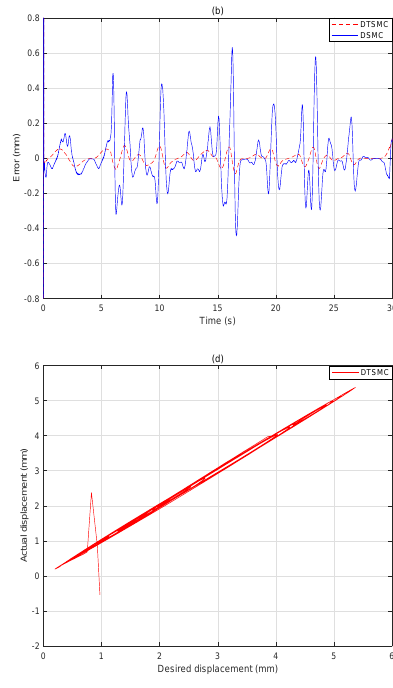
Figure 15. The tracking results under the hybrid frequency input signal. ( a ) Displacement output. ( b ) Tracking error. ( c ) Desired displacement versus actual displacement of the DSMC. ( d ) Desired displacement versus actual displacement of the DTSMC. Table 6. The tracking-error results of the DSMC and DTSMC controllers at different